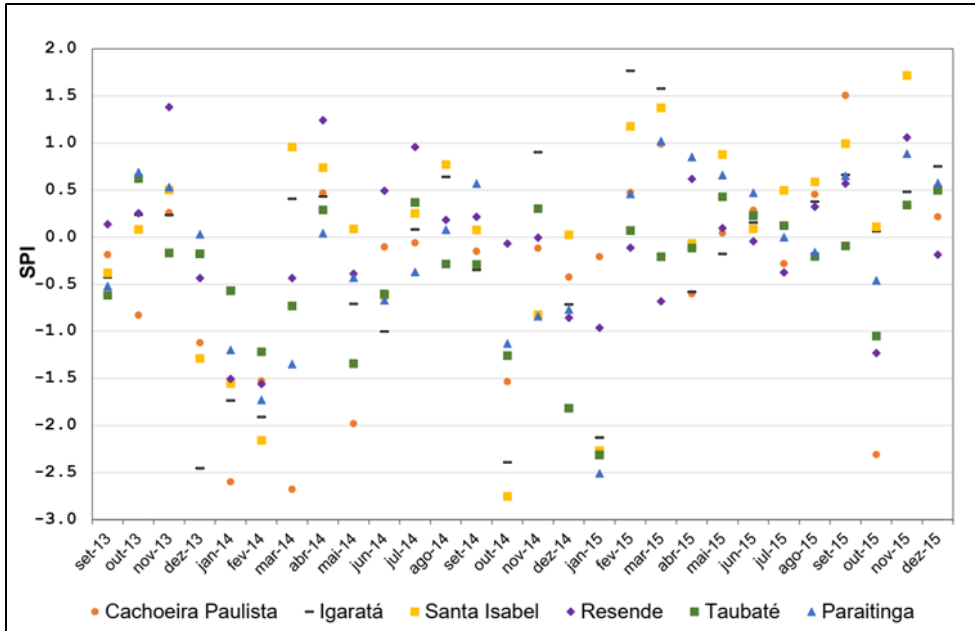
Figure 6. Monthly SPI of rainfall gauges in the region under study.